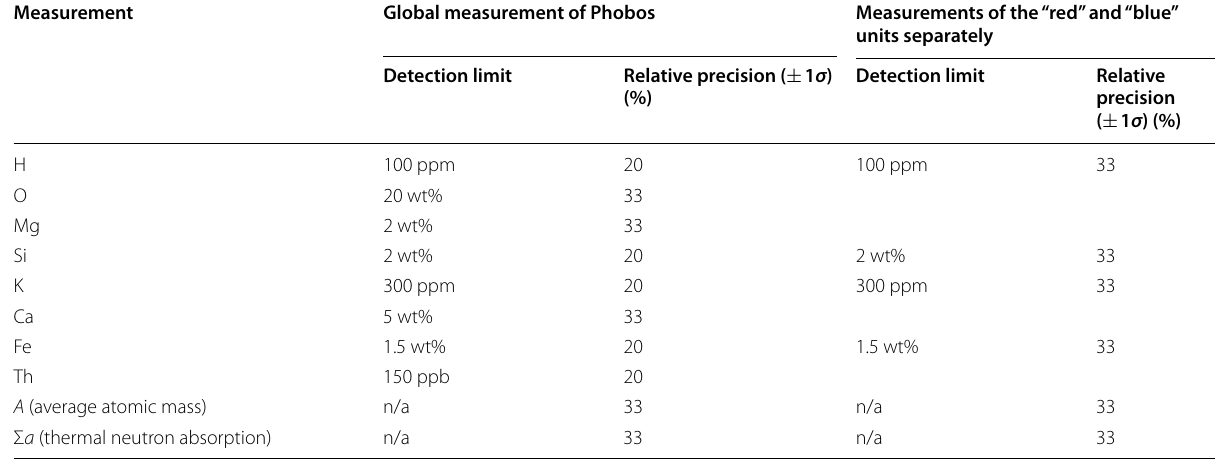
Table 4 MEGANE required measurements from low‑altitude QSO observations